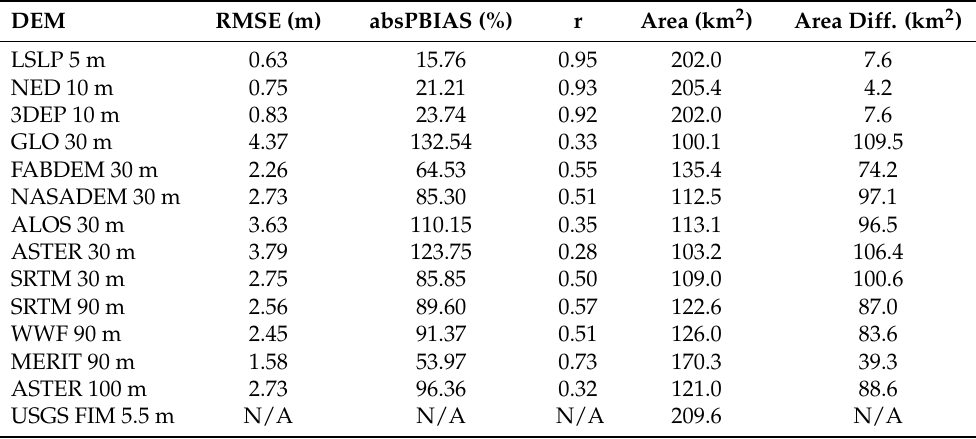
Table 4. Error metrics relating FwDET-GEE output from DEMs of varying spatial resolutions to the USGS FIM (5.5 m spatial resolution) reference flood depth dataset. The area difference column compares each output to the USGSFIM reference layer (USGSFIM area minus FwDET output